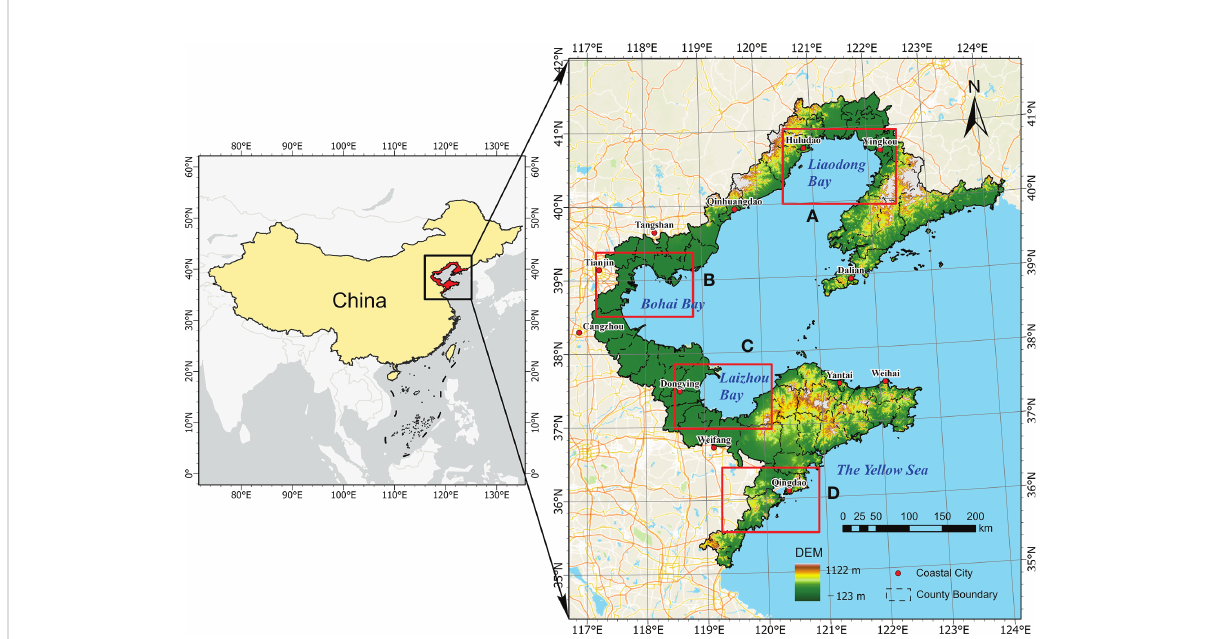
FIGURE 1 Overview map of the study area. The panel on the left shows the location of the study area, and the right shows the bay areas and important port cities included. Red boxes and labels on the right indicate the spatial extents of regional examples shown in Figure